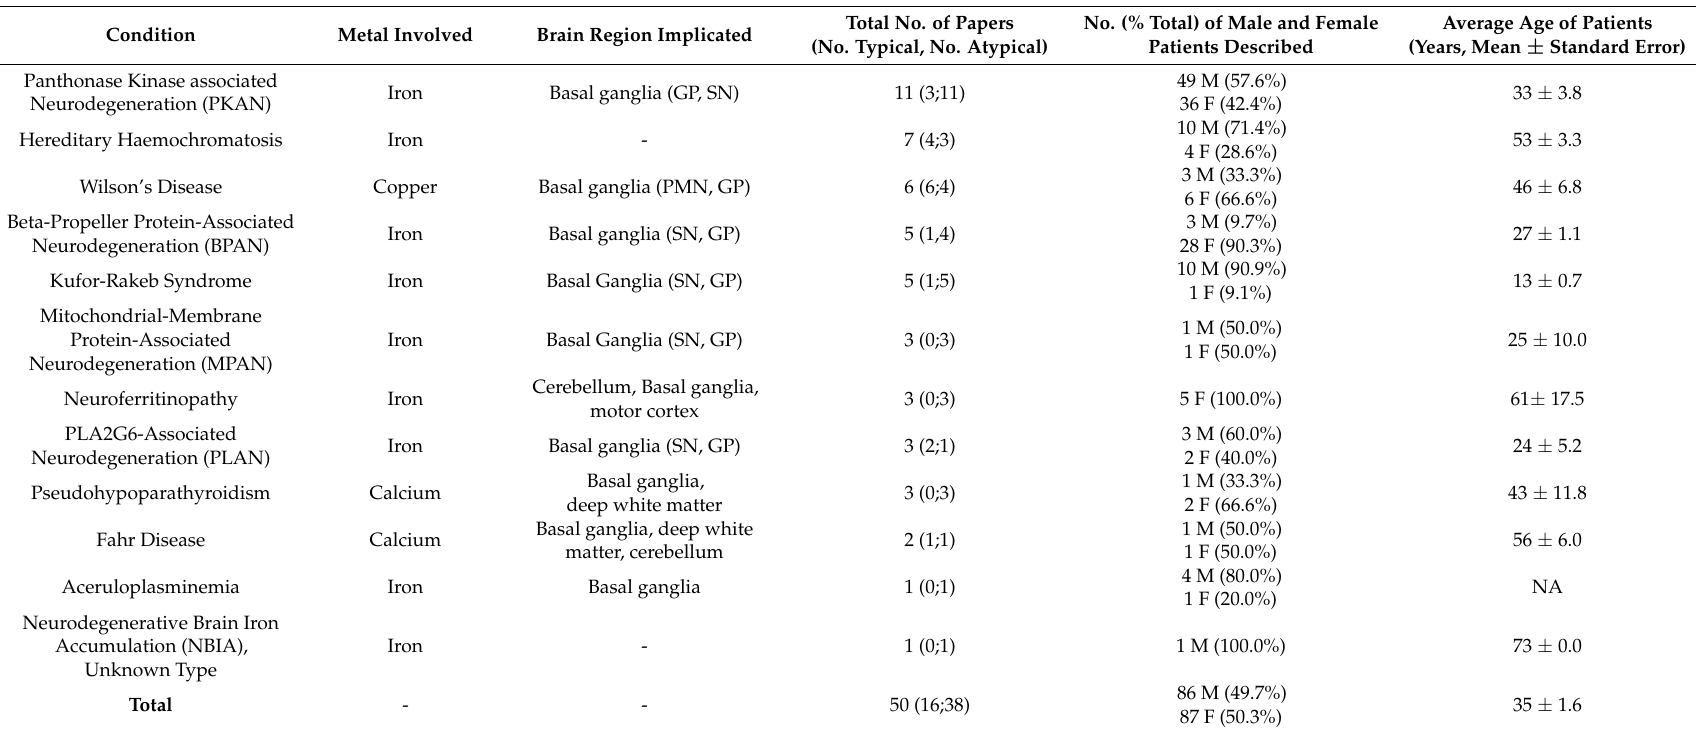
Table 2. Characteristics of the disorder-related parkinsonism described in the included publications, in order of the number of papers